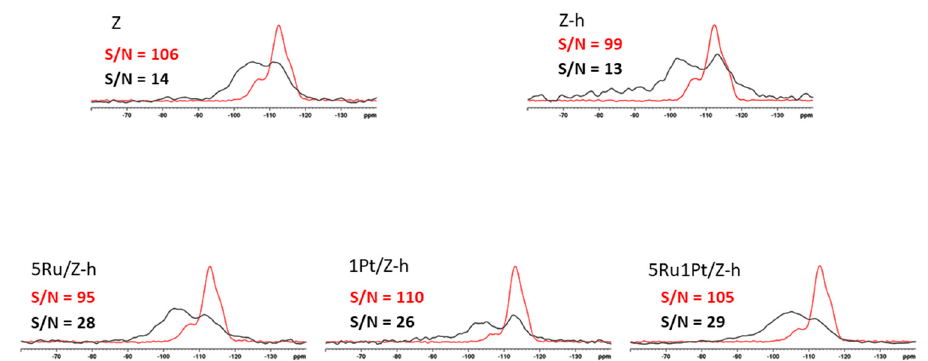
Figure 9. Comparison of the 1 H → 29 Si CP (black) and single-pulse (red) 29 Si NMR spectra of the studied zeolites.